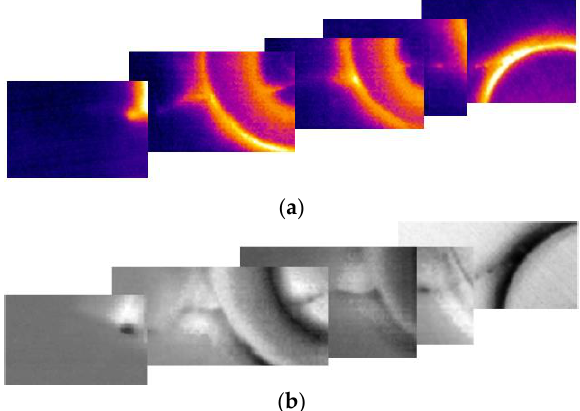
Figure 9. Crack reconstruction using ( a ) raw IR images and ( b ) a reconstructed image by the second principal component.